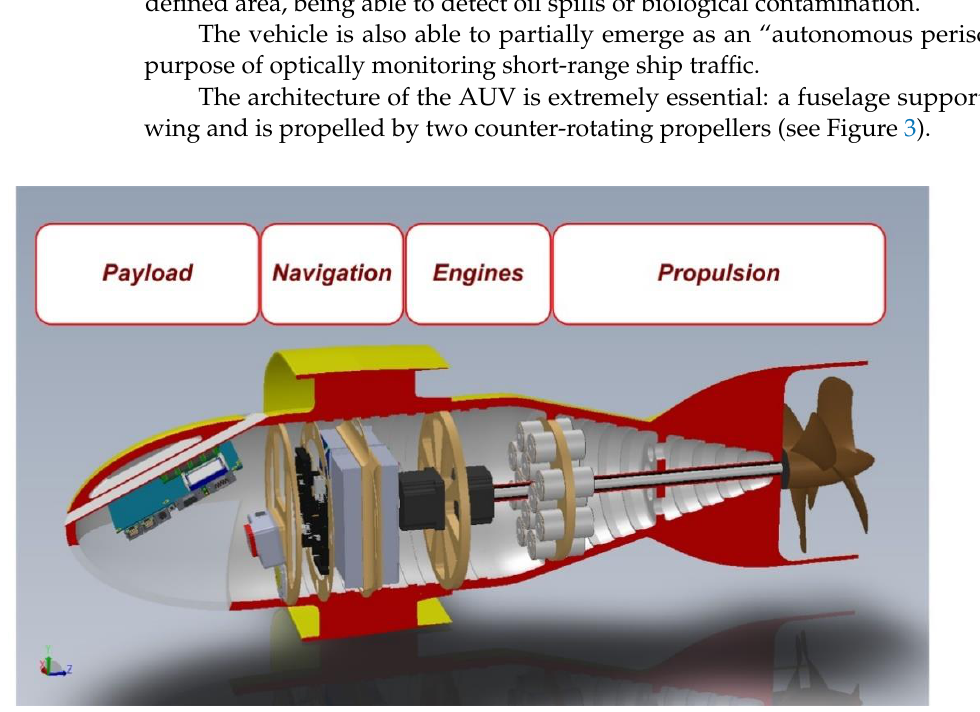
Figure 3. Section of AUV Albacore.